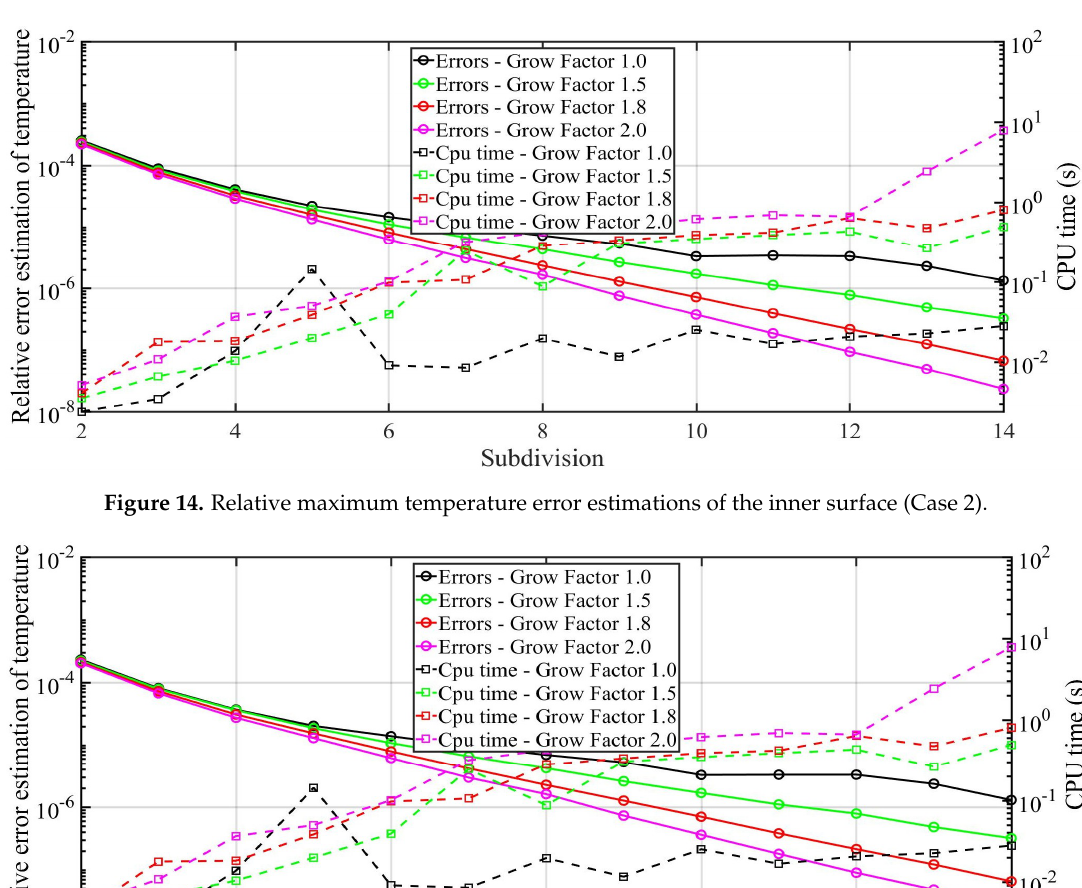
Figure 13. Absolute maximum temperature error estimations of the outer surface (Case 2).